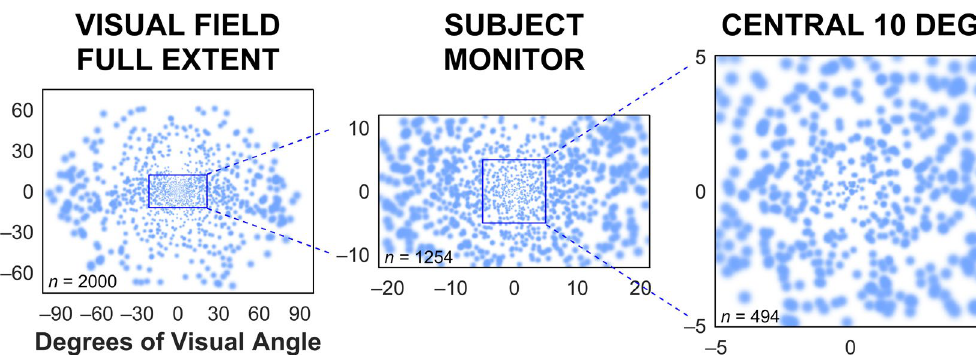
Figure 8. Phosphene pattern. The phosphene pattern used in this experiment contained 2000 phosphenes total, spread over the entire visual field in a center-weighted pattern that follows the natural profile of visual acuity from the center of gaze to the periphery 5, 67 , as seen in the left image. During the task, the phosphenes that fall on the subject monitor would be simulated. As the pattern is gaze-locked in retinotopic coordinates, the pattern is shifted with gaze movements during the simulation, and the number of phosphenes that fall on the monitor accordingly varies; that number would be maximum at about 1200 phosphenes when the gaze position was straight ahead, as seen in the middle image. In phosphene view mode, those phosphenes would be used as a filter on the image to be presented to the subject (see Figs. 7, 9). The central part of the visual field that carries the highest density of phosphenes is shown in the right image. For phosphene patterns in this class that model thalamic visual prostheses under development in our laboratory, the central 10 degrees typically has about one- quarter of the total phosphenes 51